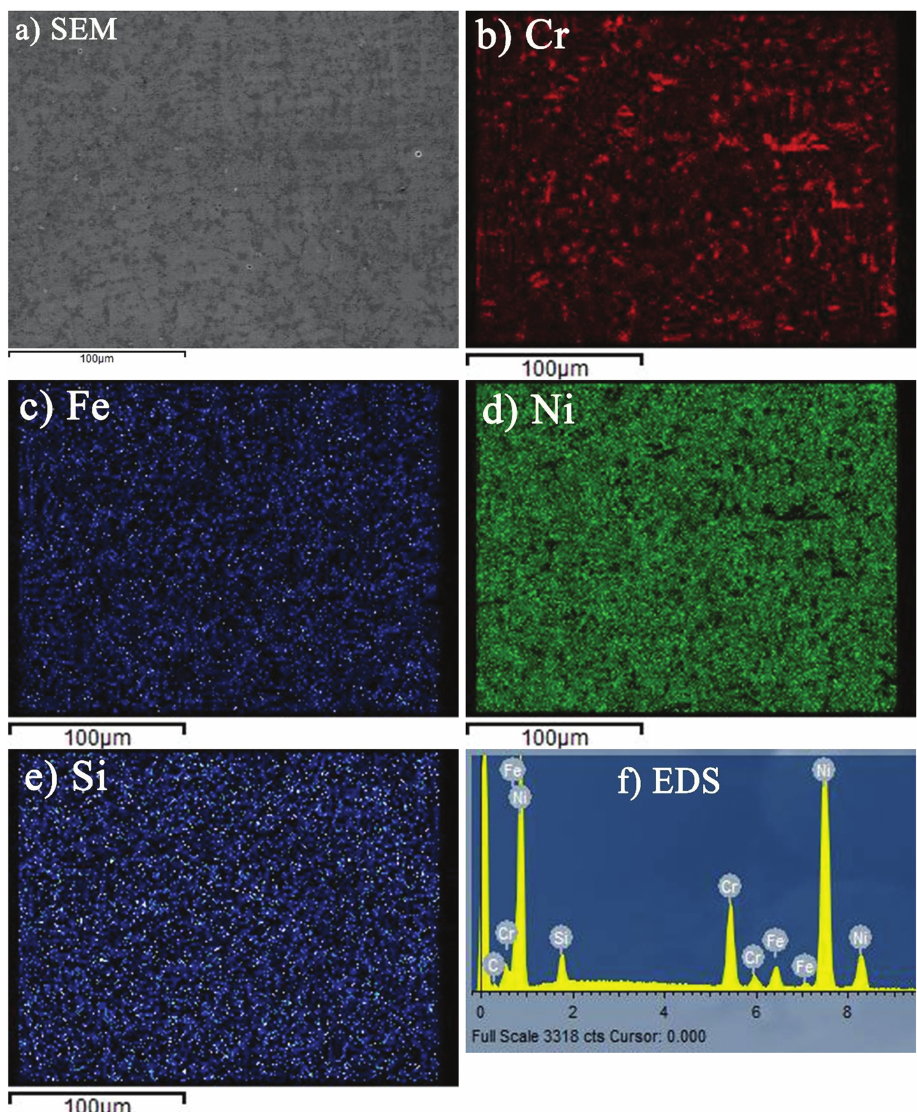
Figure 10: Scanning electron micrograph of the deposit, EDS and elemental